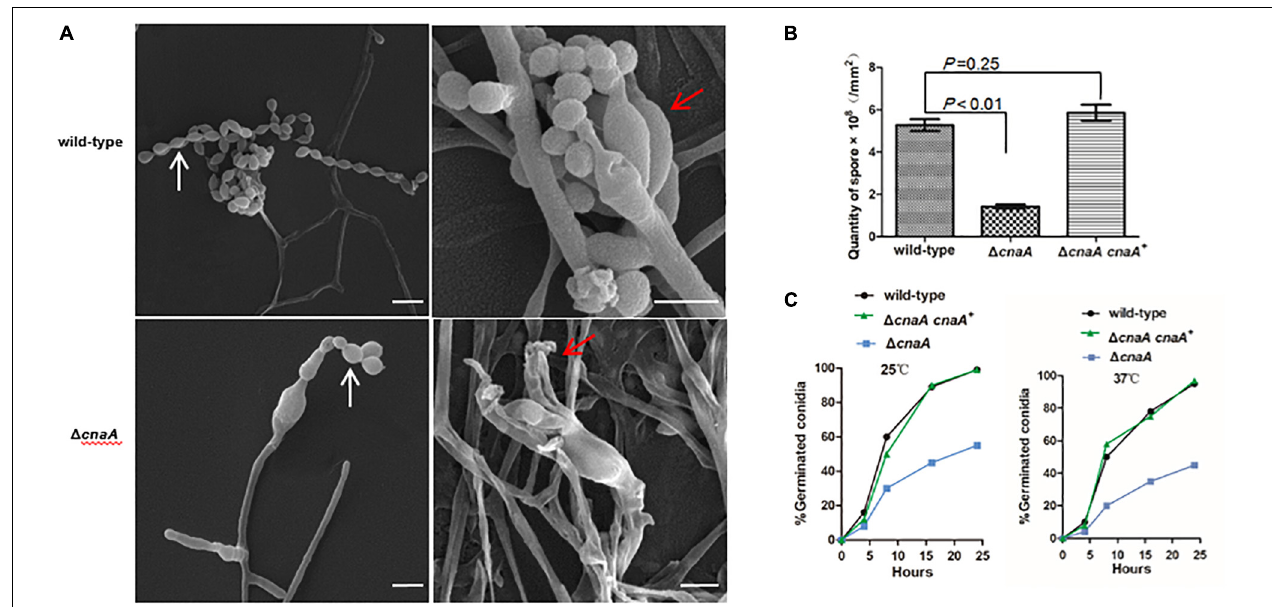
FIGURE 2 | Loss of cnaA affects conidiophore development and conidial germination. (A) Wild-type and (cid:49) cnaA strains were grown on ANM + (NH 4 ) 2 SO 4 for 14 days at 25 ◦ C and examined by SEM. The wild-type strain showed a conidiophore that was composed of four to seven phialides (red arrow) and long chains of conidia (white arrow), resulting in the production of abundant conidia. In the (cid:49) cnaA mutant, the conidiophore displayed abnormal phialide and spore chains with decreased numbers of conidia. Scale bars, 10 µ m. (B) Compared with the wild-type and (cid:49) cnaA cnaA + complemented strain, the (cid:49) cnaA mutant showed a statistically significant decrease in conidial density ( P < 0.01). (C) The kinetics of germination were measured at both 25 ◦ C and 37 ◦ C by counting the number of germinating conidia in a population of approximately 100 spores after incubation for 4, 8, 16, and 24 h in SD liquid medium. In contrast to the wild-type, the percentage of germination decreased in the (cid:49) cnaA mutant.